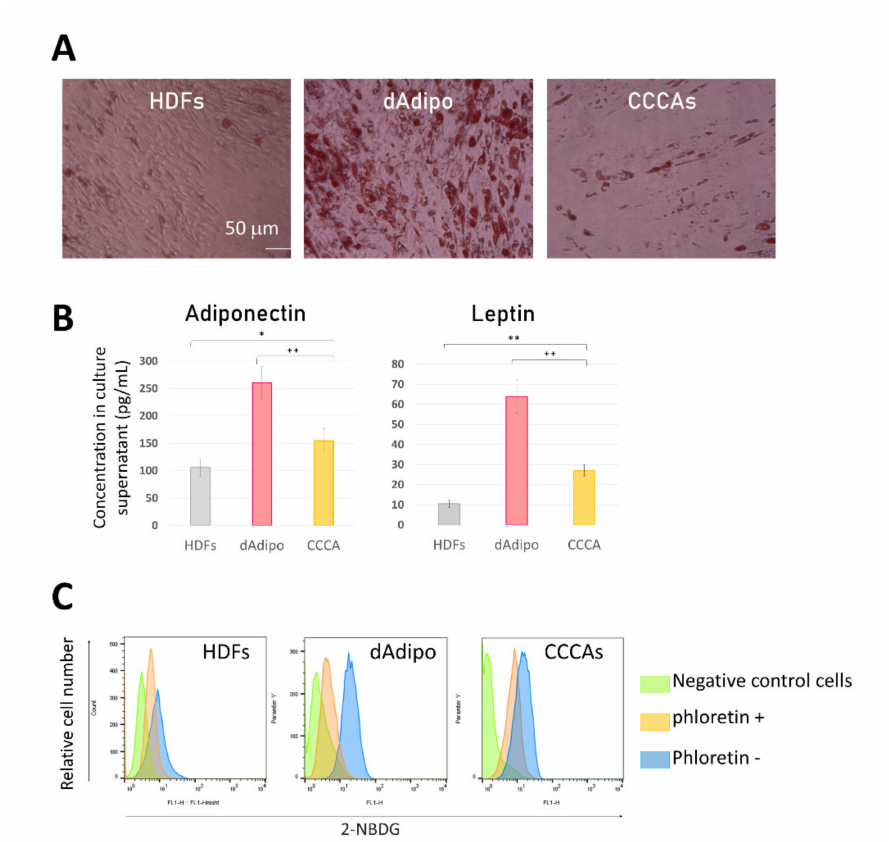
Figure 5. CCCAs have mature adipocyte-like functions in vitro. ( A ) HDFs, differentiated adipocytes (dAdipo), and CCCAs were stained with OilRed O. Optical light microscopic images are shown (original magnification: × 100). ( B ) Culture supernatants of the indicated cells were subjected to ELISA for measurement of concentrations of the indicated adipokines. ( C ) Cells were or were not pretreated with phloretin and were then tested for incorporation of 2-NBDG in the presence or absence of Glucose Uptake Enhancer. Cells were analyzed by means of flow cytometry. Representative histograms for green fluorescence are shown. * p < 0.01, ** p < 0.001 vs. control group; ++ p < 0.01 vs. dAdipo